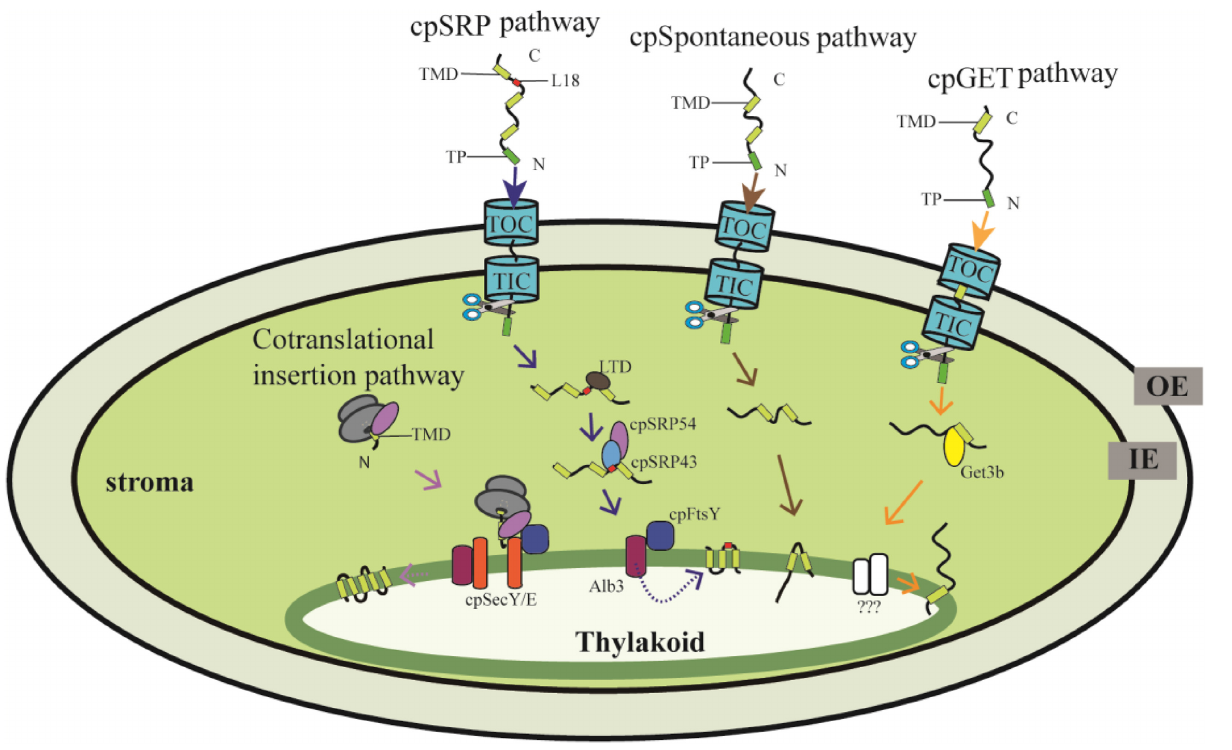
FIGURE 1 | Proteins targeting into thylakoid membranes through distinct pathways. The nuclear-encoded preprotein with an N-terminal transit peptide (TP) is translocated into the chloroplast stroma through the Toc/Tic system, and then the TP is cleaved by stromal processing peptidase. The thylakoid membrane proteins are further targeted mainly through the cpSRP pathway, cpGET pathway and the spontaneous pathway. In the cpSRP-dependent pathway, LHCP is transferred from the Toc/Tic system to the SRP43/SRP54 complex with the help of LTD., cpSRP43 interacts with the L18 region between the second and third TMD of LHCP. Then the cpSRP/LHCP complex interacts with cpFtsY and finally LHCP is insert into the thylakoid membrane by the integrase Alb3. In the cpGET pathway, imported TA proteins are transferred to the targeting factor Get3b, followed by transferr to the unknown integrases. Some proteins are translocated into thylakoid membranes spontaneously. On the other hand, the chloroplast-encoded proteins are synthesized in the stroma, and cotranslationally integrated into the thylakoid membrane with the requirement of cpSec and cpSRP components. OE, outer chloroplast envelope; IE, inner chloroplast envelope. TP, transit peptide. TMD, transmembrane